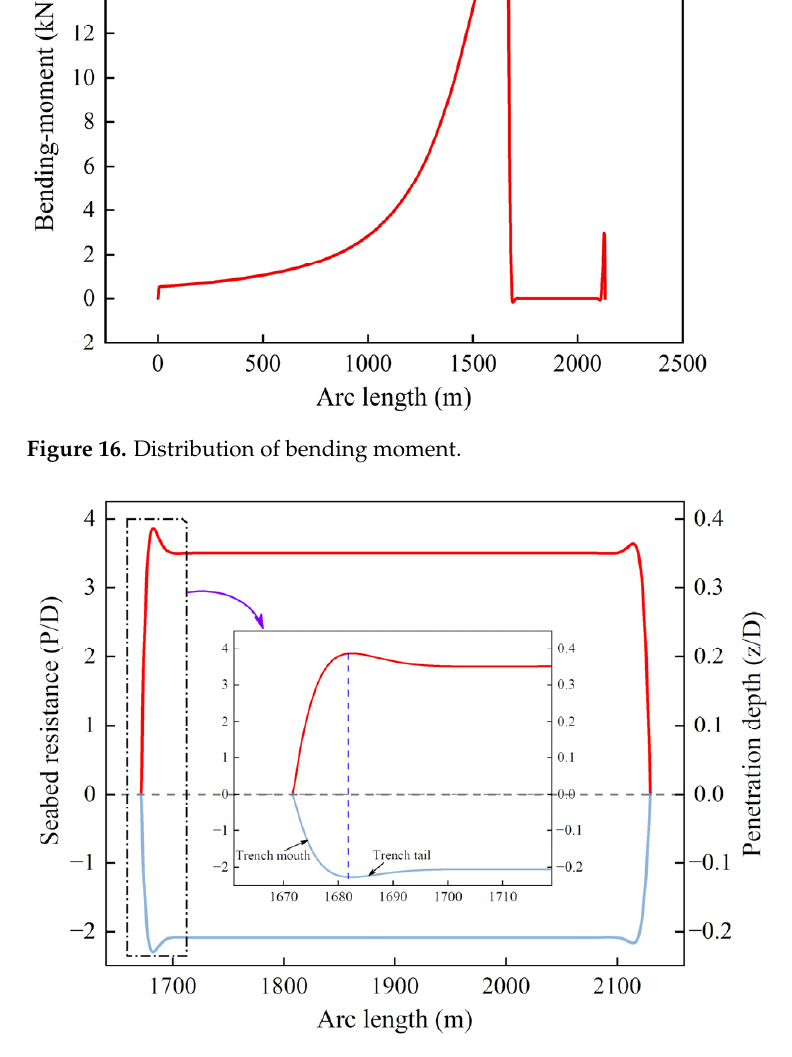
Figure 17. Distribution of seabed resistance and developed seabed trench. A reference point P at the arc length of 1660.0 m was taken as the truncated point in the model test. The vertical clearance between point P and the seabed was 0.3 m when the static configuration of SCR was established. After applying a harmonic heave motion with an amplitude of 1.0 m and a period of 15 s, the time history of the vertical displacement of point P was obtained, as shown in Figure 18. It proves that harmonic sine-wave motions are suitable to be applied to the truncated point of the model SCR. The relationship between the displacement ranges of the top end and point P is shown in Figure 19. When the heave motion reached an amplitude of 1.5 m, the moving range of point P was 0.72 m. Therefore, the applied displacement to the truncated point lay within the capability of the vertical hydraulic loading jack. Similarly, the horizontal moving range of point P was also less than the maximum displacement of the horizontal hydraulic loading